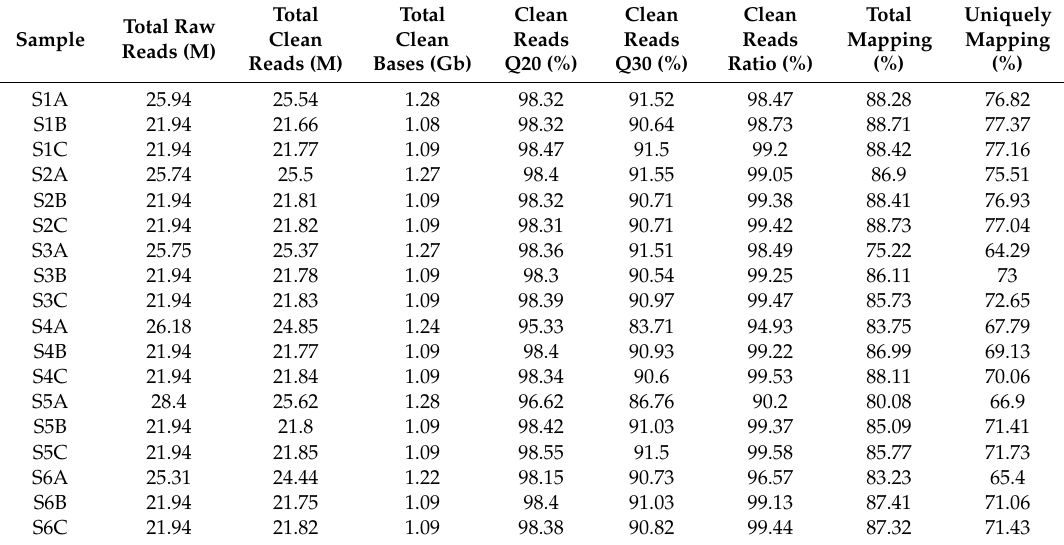
Table 1. Summary statistics of clean reads in the rhizome transcriptomes of lotus.